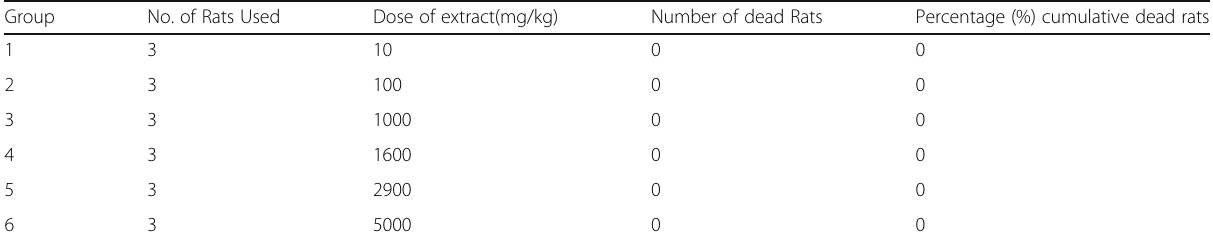
Table 2 Acute toxicity studies. There was no death recorded in all the groups during the two phases according to Lorke ’ s method